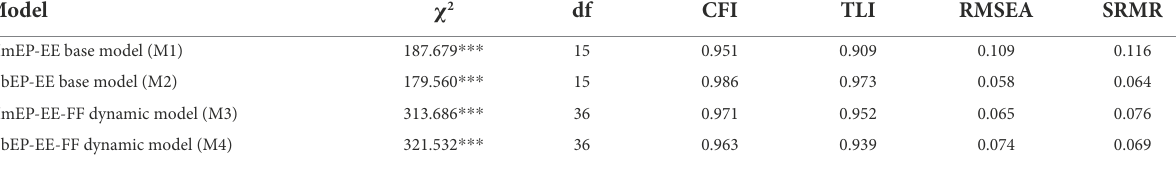
TABLE 4 Fit indices and chi-square test results for the four models.